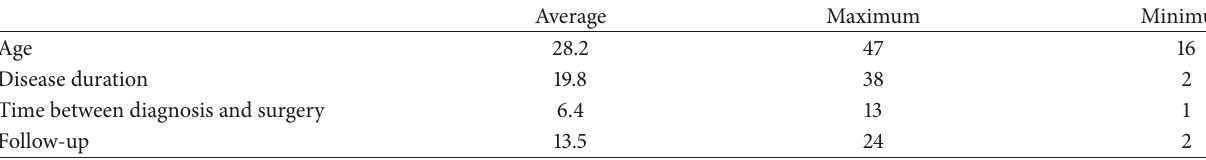
Table 1: Summarised demographic data regarding patients in the study sample.